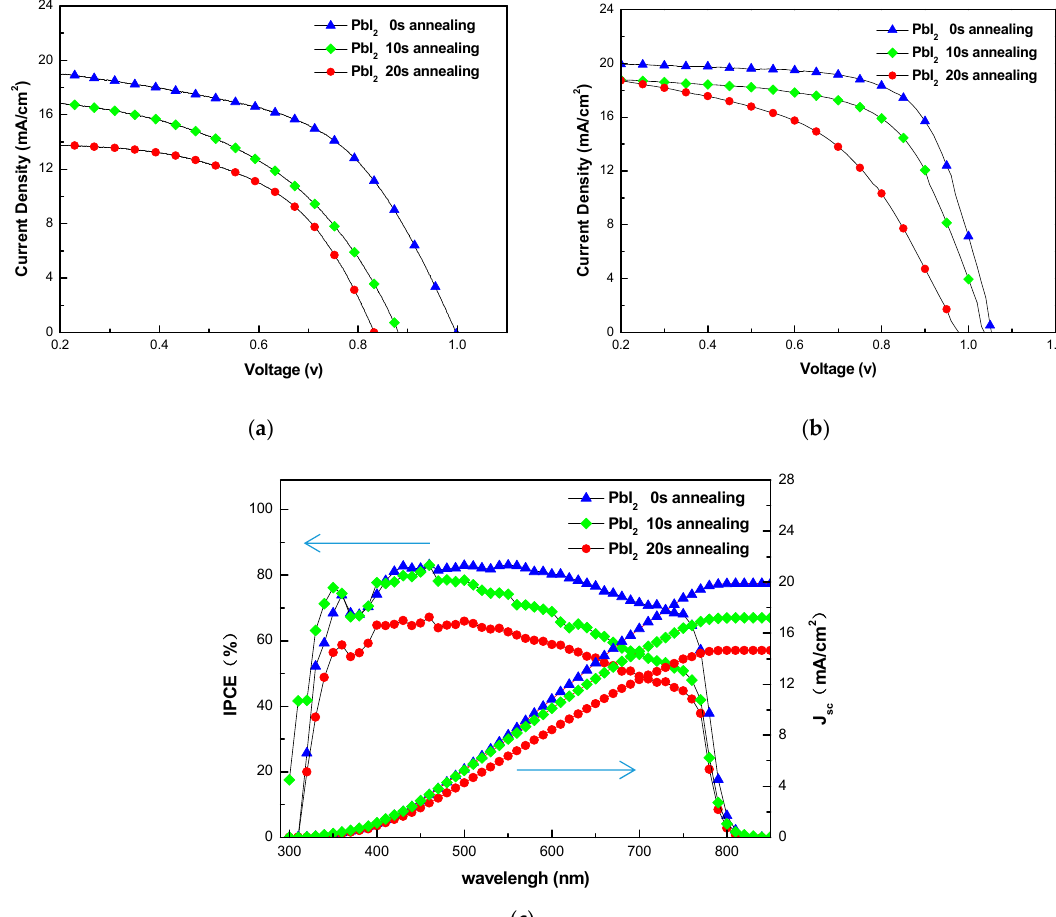
Figure 5. J-V curves from reverse scan (RS) and monochromatic incident photon-to-electron conversion efficiency (IPCE) of PSCs prepared by sequential deposition route with different PbI 2 annealing times: ( a ) J-V curves for the devices with carbon/FTO composite electrode; ( b ) J-V curves for the devices with gold electrode; ( c ) IPCE of devices with carbon/FTO composite electrode.